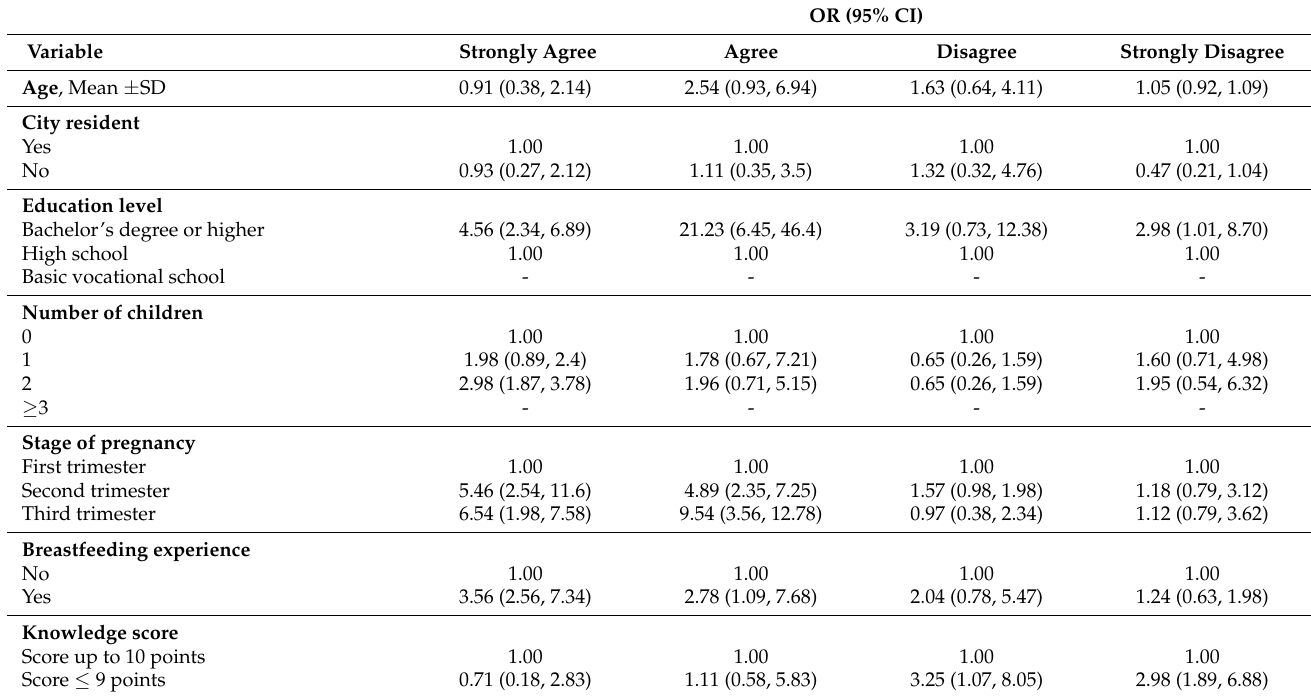
Table 6. Multiple logistic regression analysis between socio-economic and obstetric characteristics of respondents and their attitudes toward the continuation of breastfeeding based on the presence of breast milk stem